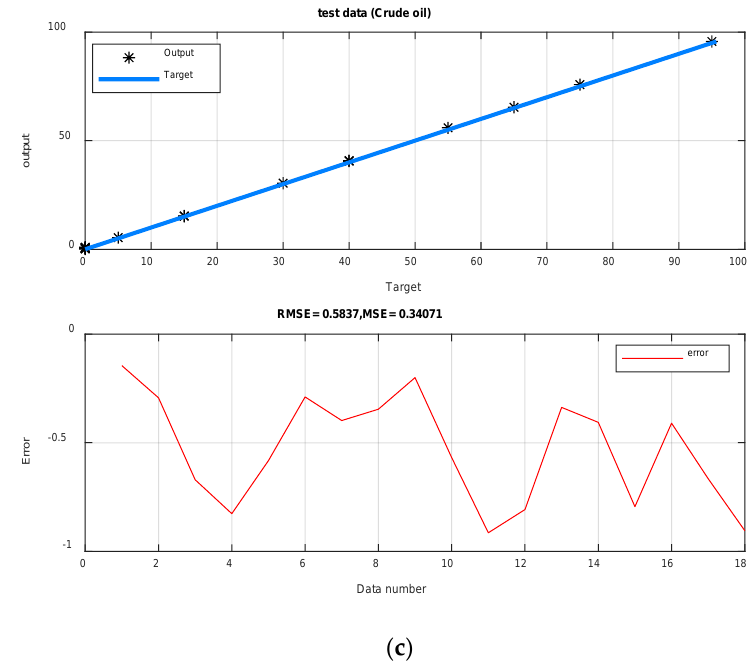
Figure 6. Network performance for predicting the volume rate of crude oil: ( a ) training, ( b ) validation, and ( c ) testing dataset.